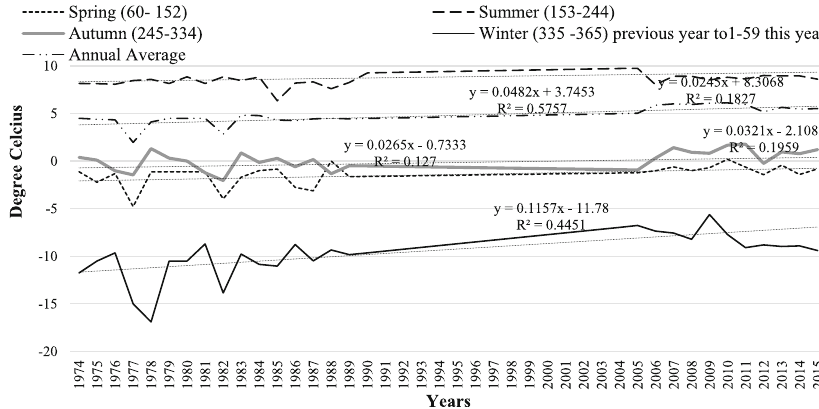
Fig. 4 Changes in Average Minimum Temperature in Upper-Mustang (Chhoser Meteorological Station), Nepal by Seasons (1974 – 2015), (Source: DHM/Govt of